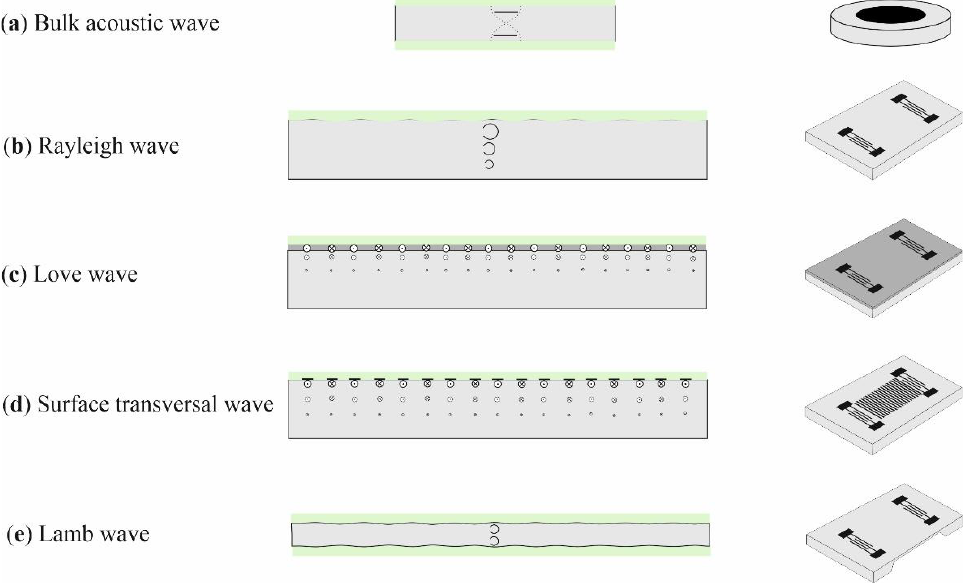
Figure 2. Wave propagation modes and acoustic wave transducers used in chemical gas sensors. The bulk wave transducers are in the form of a plate made of piezoelectric material with metallic electrodes applied on both sides (Figure 2a). Usually this material is AT-cut quartz, therefore such sensors are called quartz crystal microbalance or quartz microbal- ance (QMB). Vibrations, excited in the crystal, have the form of a shear, hence the name TSM (transverse shear mode) sensors can also be found.